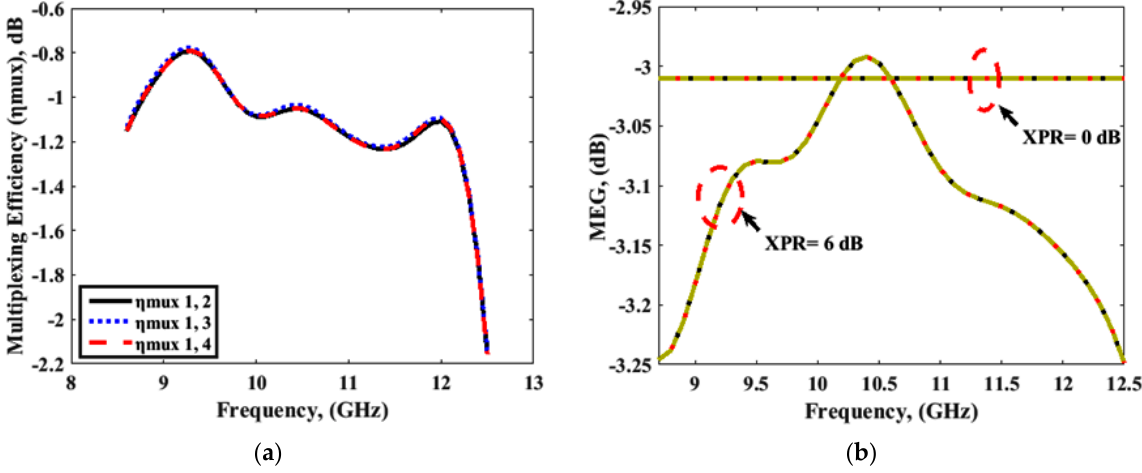
Figure 20. ( a ) Multiplexing efficiency ( η mux ), and ( b ) mean effective gain (MEG).